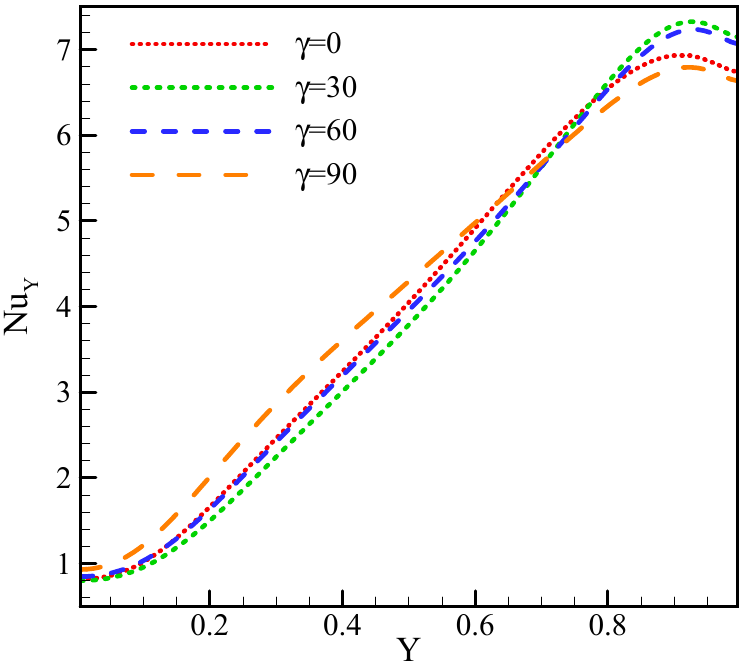
Figure 10. Local Nu for Ra = 10 5 , Rd = 1, Ha = 20, AR = 0.45 − 0.6, ω = 0, ϕ = 0.03, and various MGF angles.